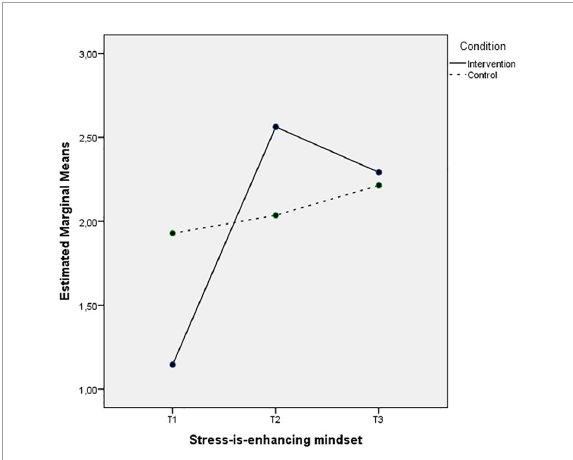
FIGURE1 Mean of SIEM showing time effects for control and intervention groups.